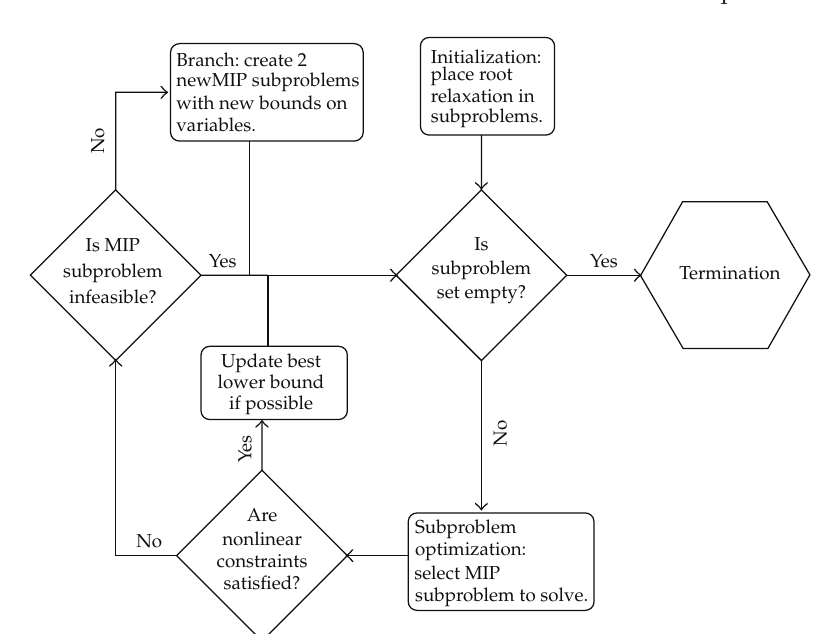
Figure 2: Flowchart of the steps involved in RLT branch and bound procedure applied to a nonlinear mixed-integer